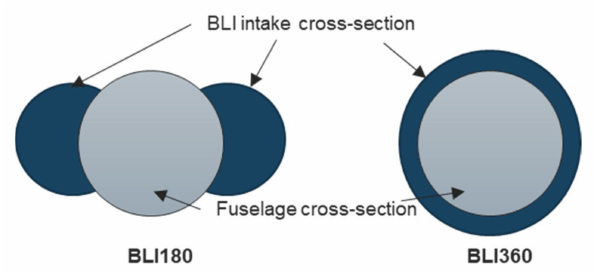
Figure 1. Illustrative diagrams of BLI180 ( left ) and BLI360 ( right ) concepts for TWB configurations.